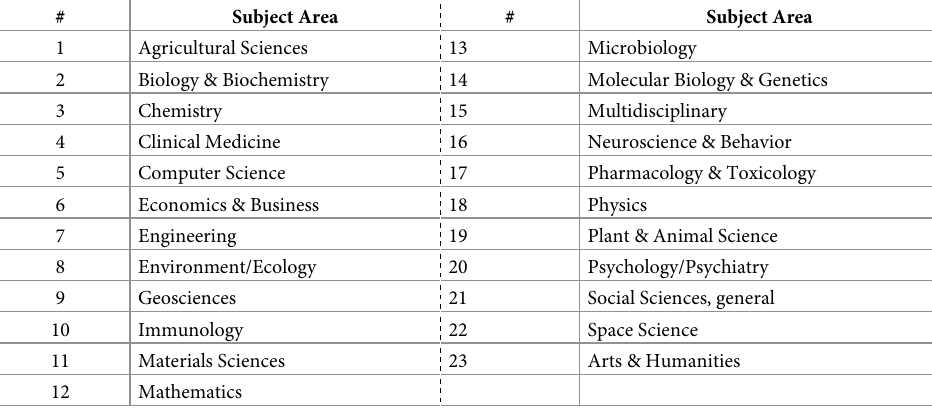
Table 2. Classification of research